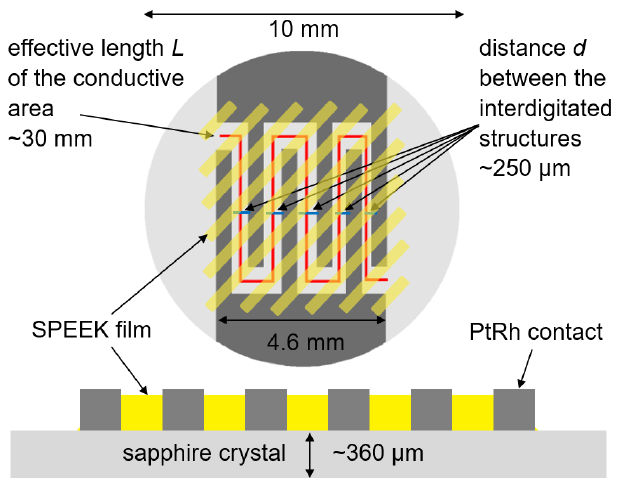
Figure 3. Scheme of the prepared sapphire crystal for proton con- ductivity measurements.